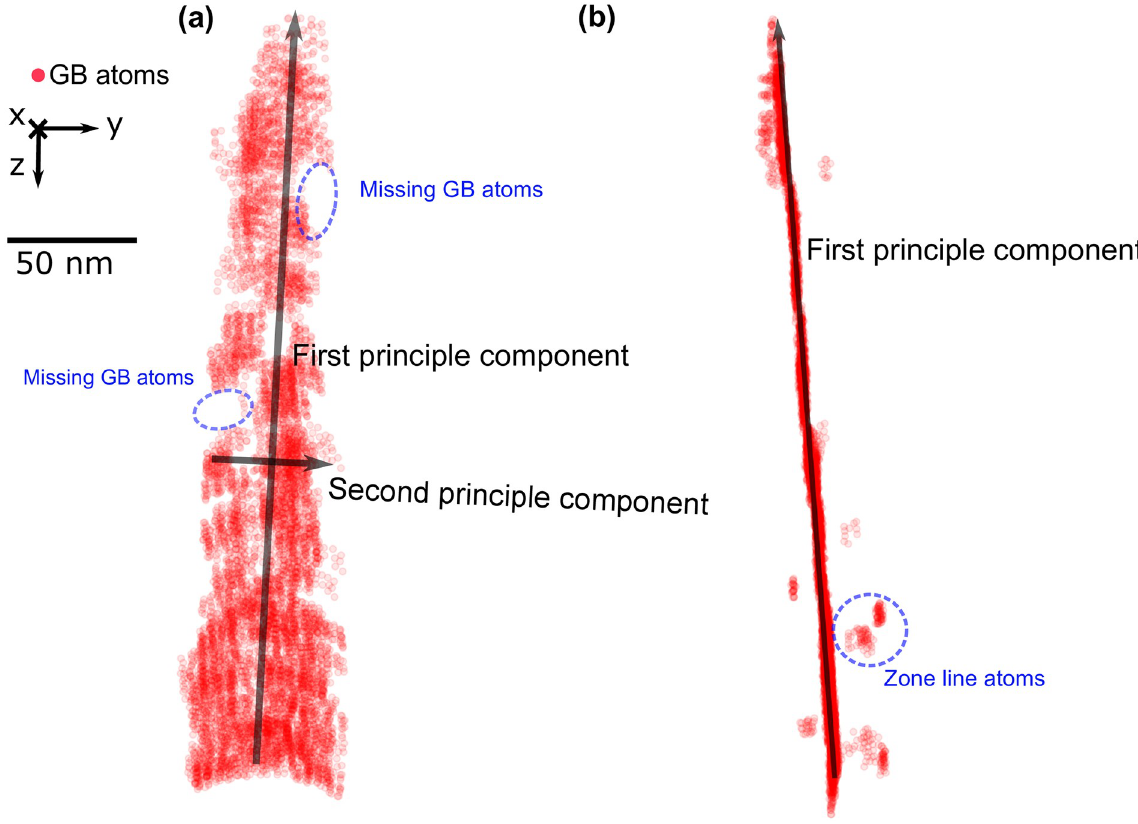
Fig 8. Visualization of GB atoms and principal components. (a) Front view of GB atoms, first and second principal vector are plotted, on this two components the variance are the highest. Additionally some GB atoms are missing mainly due to the limited size of tracking window. (b) Side view of GB atoms, a few zone line atoms can be seen as